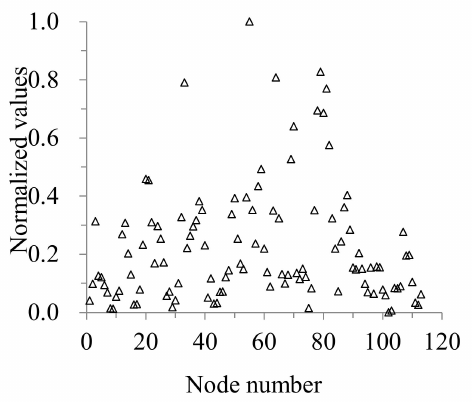
Figure 6. Normalized values of node betweenness.